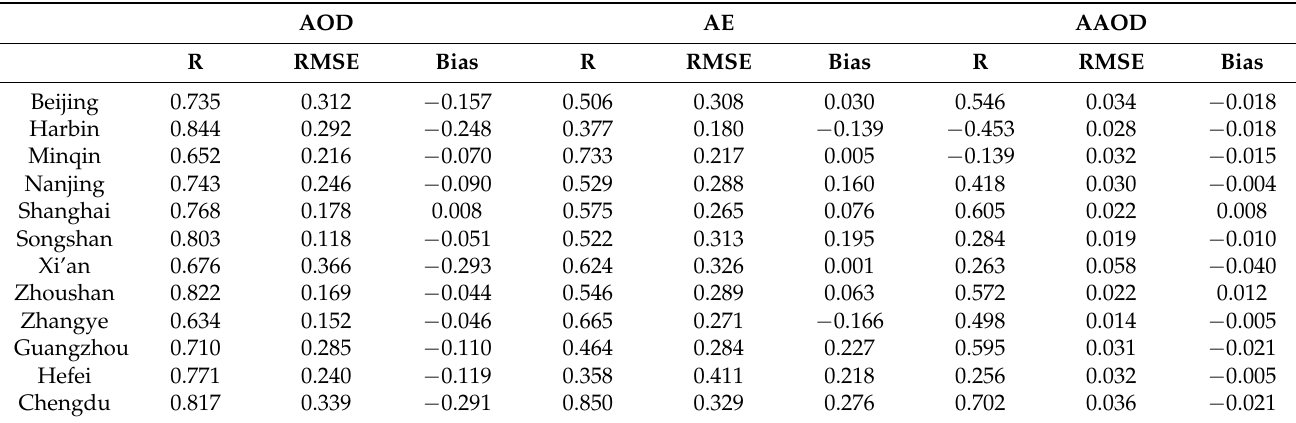
Table 2. The statistics R, RMSE, bias of AOD, AE, AAOD of the